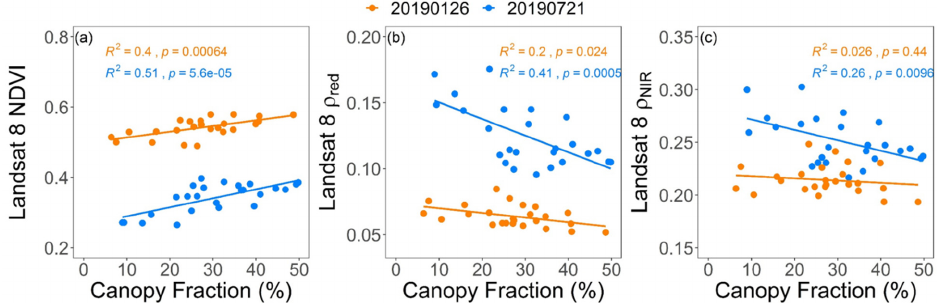
Figure 9. Correlations of canopy fraction with Landsat 8 data of ( a ) NDVI, ( b ) red reflectance, and ( c ) NIR reflectance. Each data point represents one Landsat 8 pixel in the tower area. The satellite data were taken on two Landsat 8 imaging days (21 July and 26 January 2019). The canopy fractions were calculated from two UAV flights on 31 July and 23 January 2019.